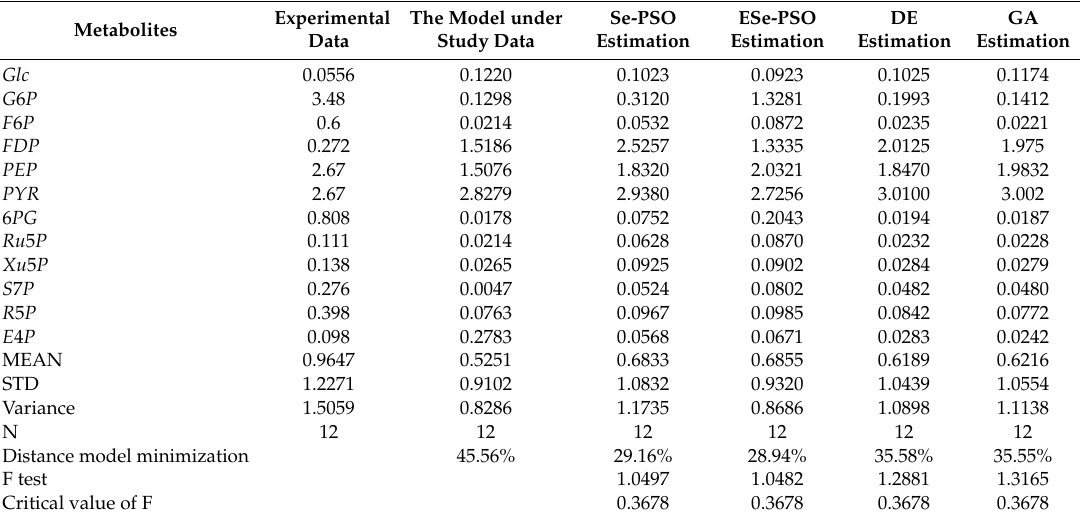
Table A4 describes the STD, MEAN, Variance and F test of the simulated